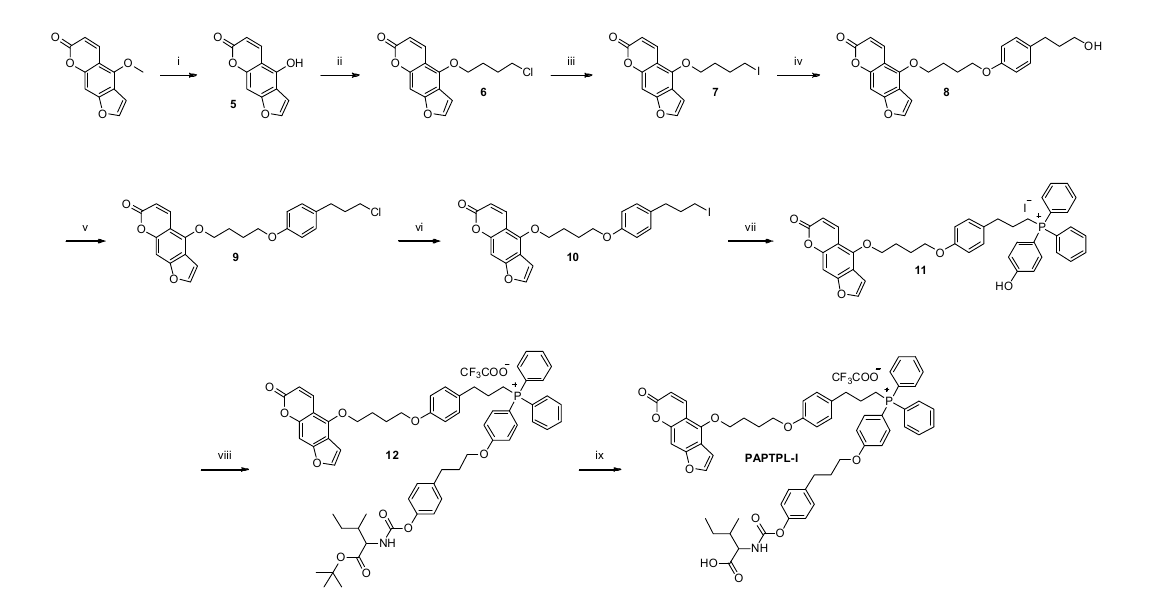
Scheme 1. Synthesis of PAPTPL-I. Reagents and conditions: ( i ) BBr 3 , DCM, r.t. for 100 min, 98% yield; ( ii ) 1-bromo-4-